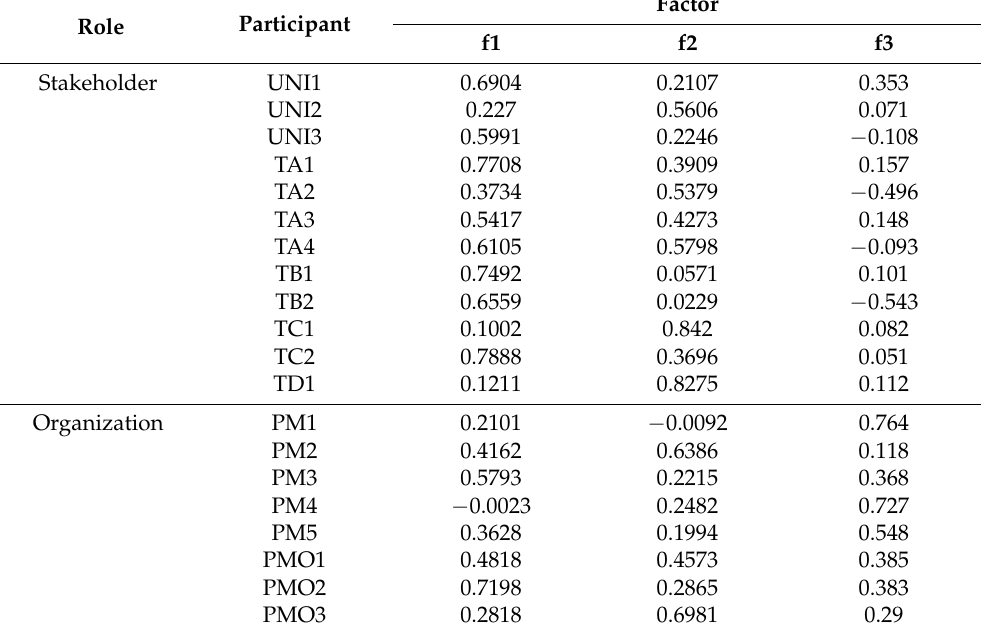
Table 8. Factor analysis.